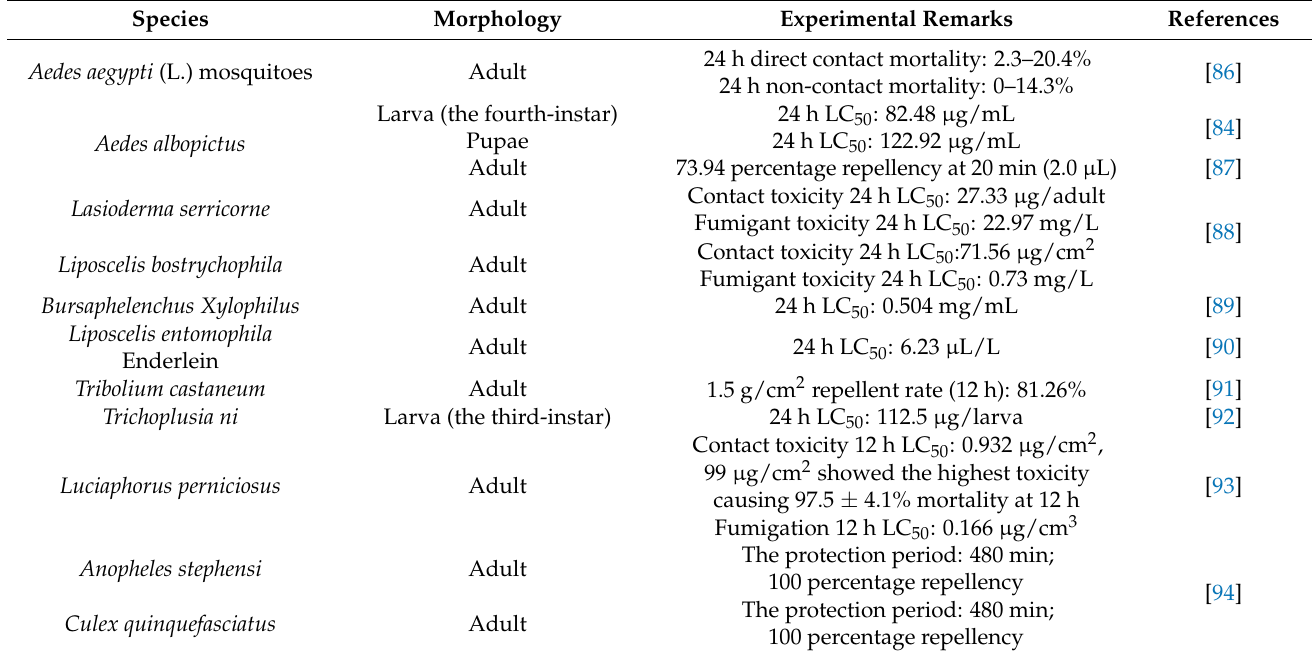
Table 4. Repellent effects of Litsea cubeba essential oil on various growth forms of mosquitoes and insects. Species